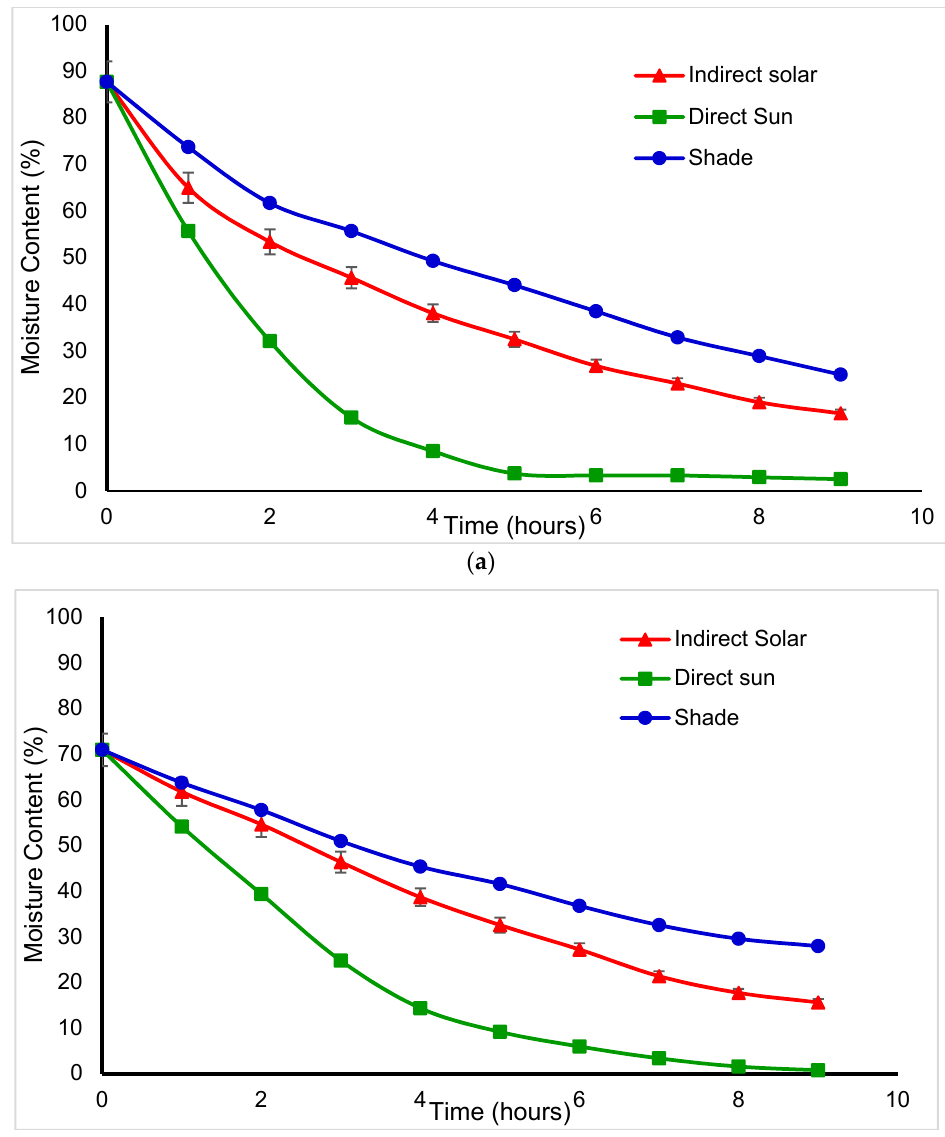
Figure 2. The moisture content reduction in ( a ) Basil and ( b ) Mint during winter.